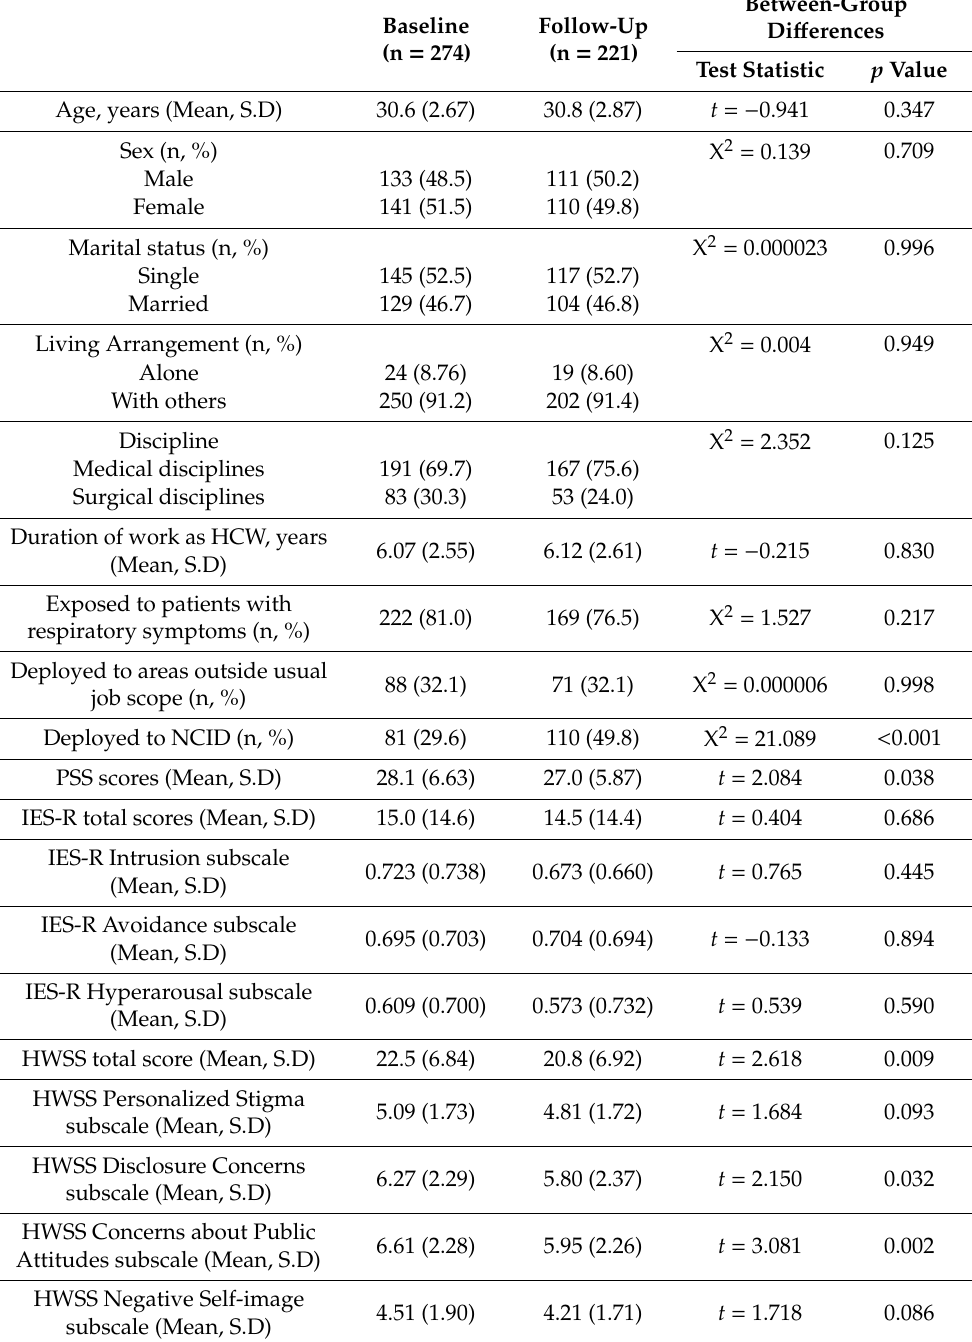
Table 1. Demographic and clinical variables of all residents (baseline vs.